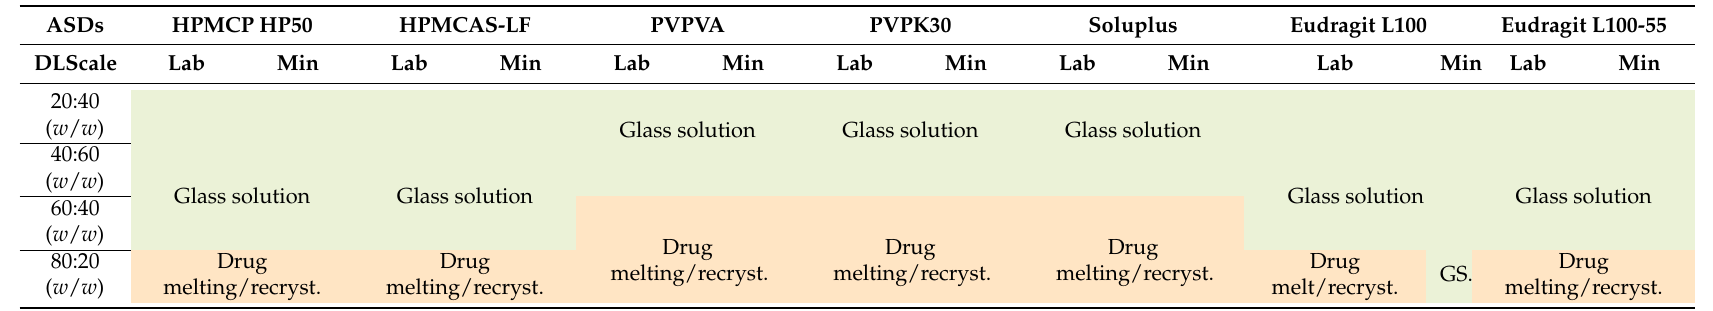
Table 3. Reproducibility of the miniaturized device (Min) to predict the phase behavior of itraconazole solid dispersions produced at laboratory scale (Lab) with